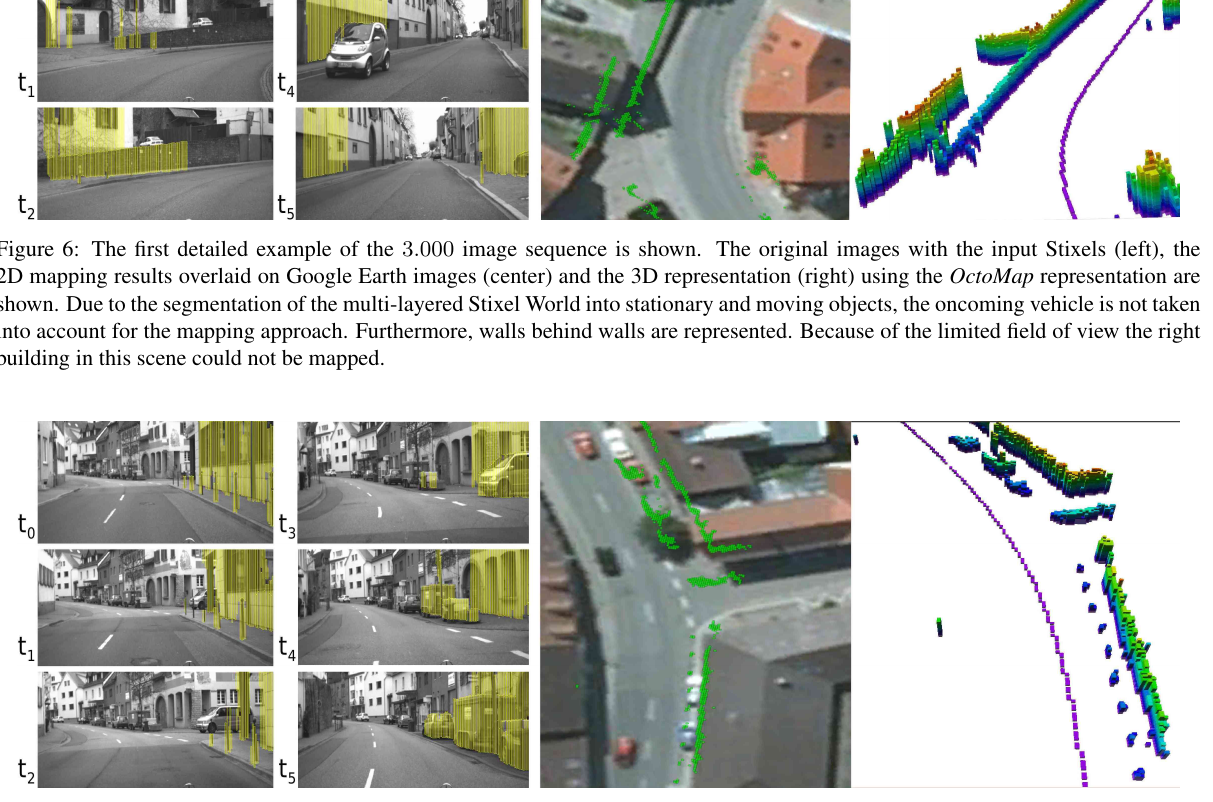
Figure 7: The second detailed example of the 3 . 000 image sequence: Traffic infrastructures like poles are mapped precisely into the map which is shown on the right side of the driving corridor. Because of the fact that the vehicle at the intersection is still waiting, it is classified as a stationary object. As a result, the vehicle is represented in the map. The mapped corners of buildings, the facades and the parking areas are consistent with the Google Earth images. Note that uncertainties in the ego vehicle’s position have not been taken into